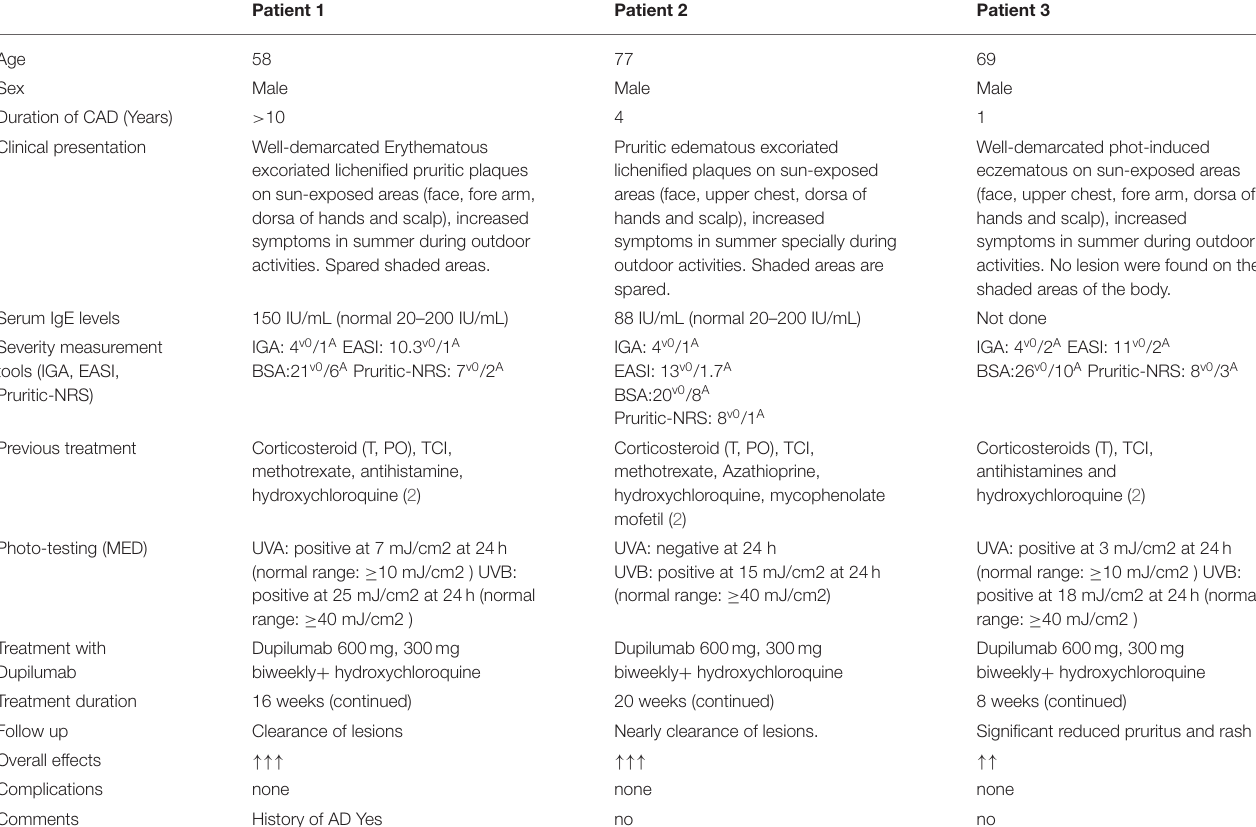
TABLE 1 | Patients with chronic actinic dermatitis (CAD) treated with dupilumab ( n =